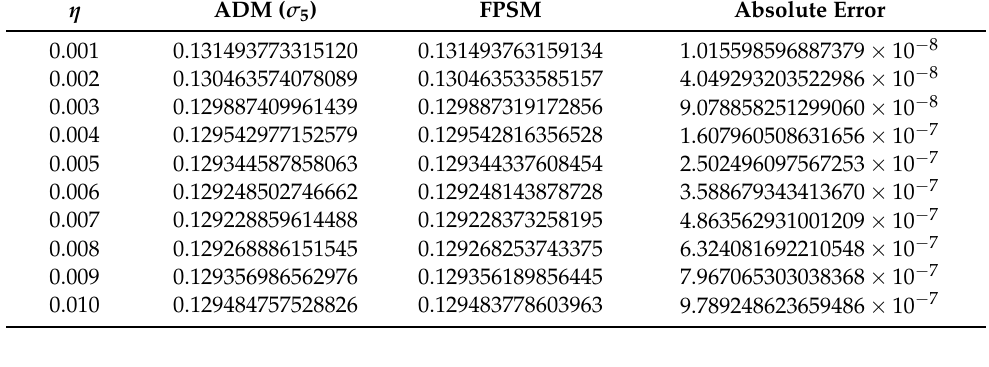
Table 2. Comparison of the numerical solutions and absolute errors for Equation (33).